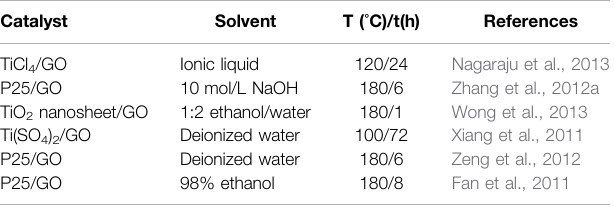
TABLE 1 | Method for preparing GT under different reaction